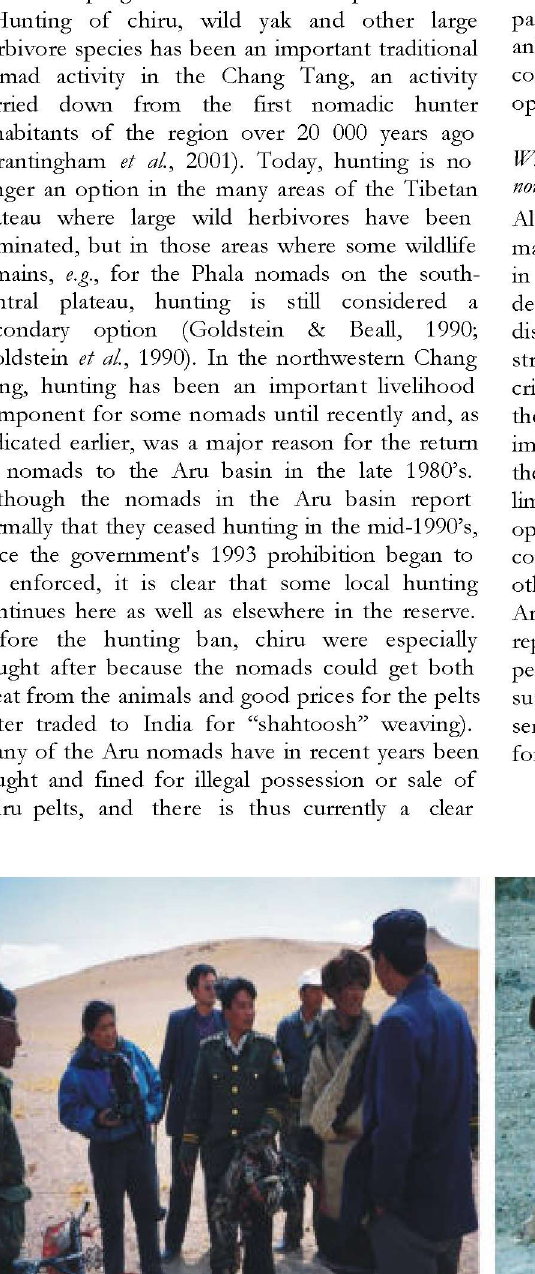
Fig. 5. Confiscation of antelope traps from a nomad (left) and chiru pelts and horns confiscated from traders (right) who bought them from nomads, both just SE of the Aru